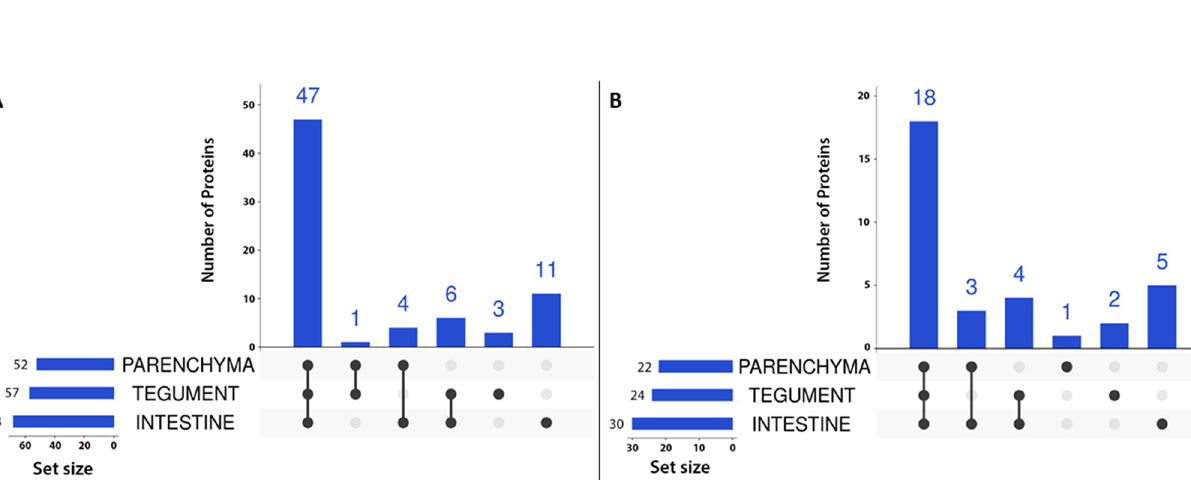
PLOS ONE | https://doi.org/10.1371/journal.pone.0231681 June 17,